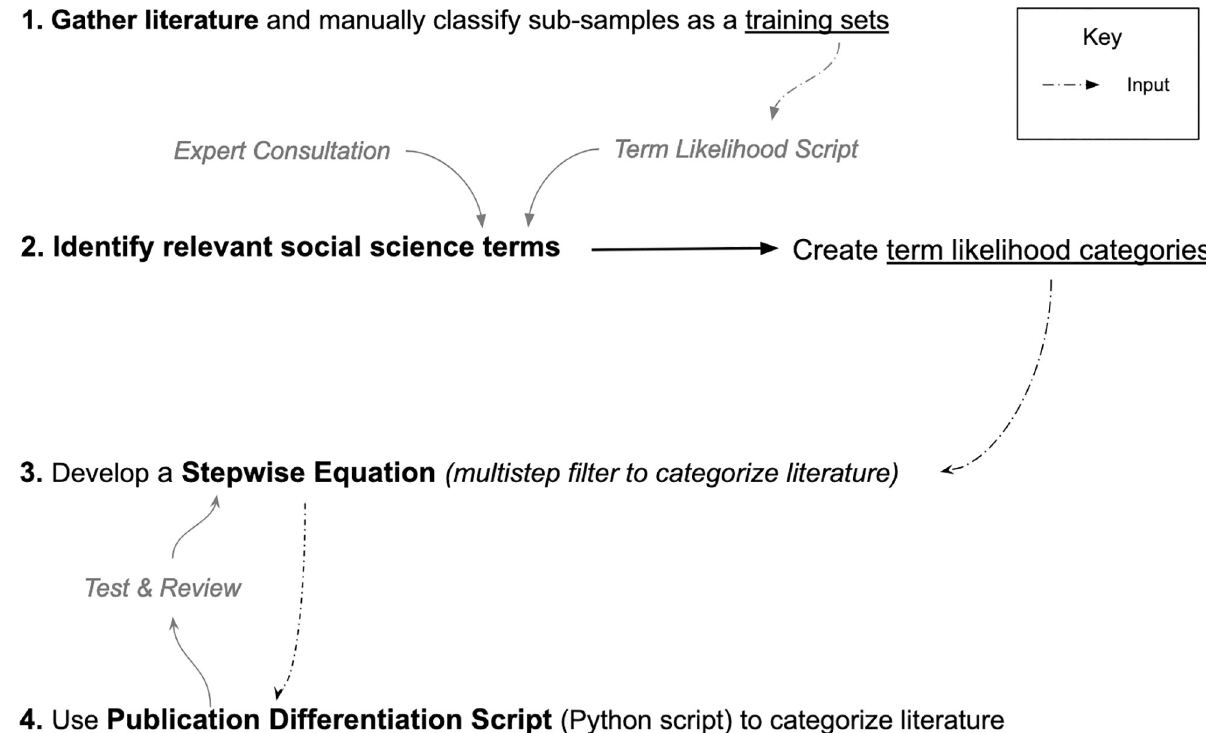
Fig 2. Developing the SEAC